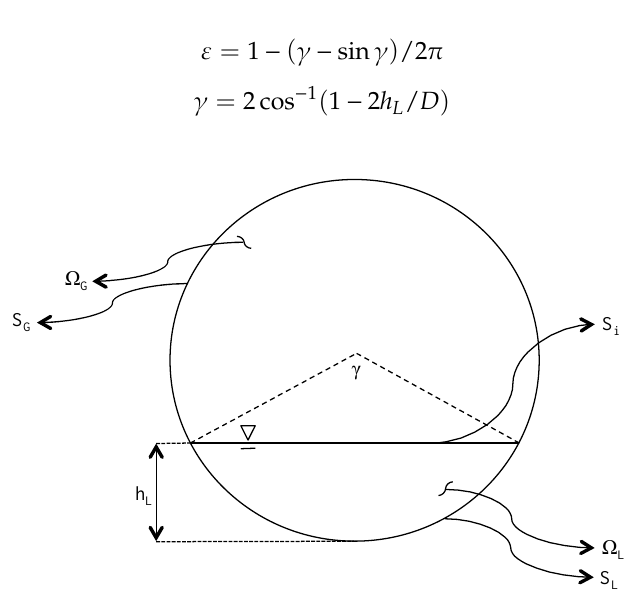
Figure 4. Resistive probe electrical scheme.